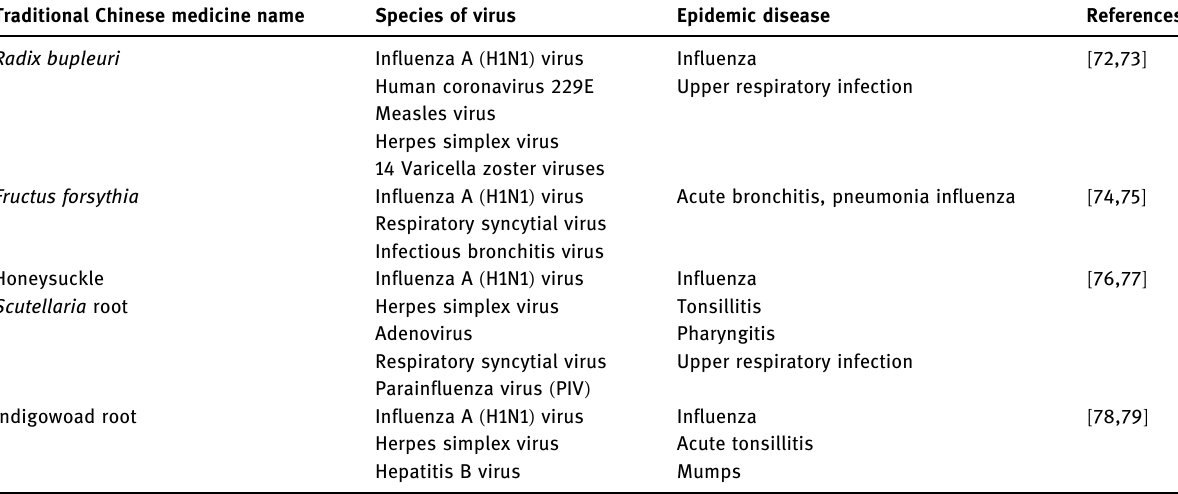
Table 1: Partial list of traditional Chinese medicine names approved by the SFDA for the treatment of viral diseases Traditional Chinese medicine